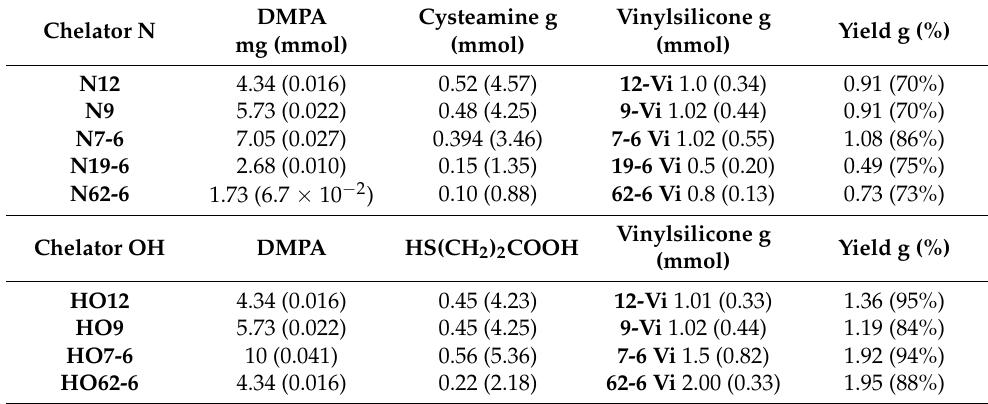
Table 3. Quantities used to prepare cyteine- and 3-mercaptopropanoic acid-derived silicones from